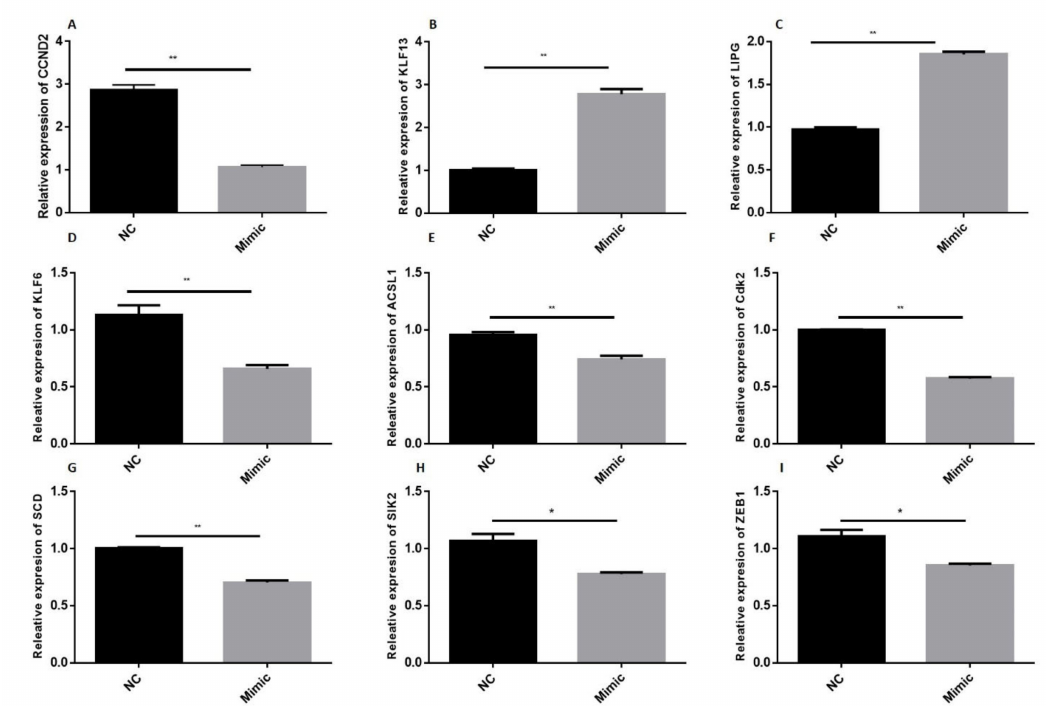
Figure 11. Validation of RNA-Seq data through qRT-PCR. Expression ( A – I ) relative mRNA levels of CCND2, KLF12, LIPG, KLF6, ACSL1, Cdk2, SCD, SIK2, and ZEB1 in bovine adipocytes transfected with bta-miR-149-5p mimics or mimics negative control (NC). The values exhibit the mean ± SEM (n = 3), and statistical significance is shown by * p < 0.05 and ** p <